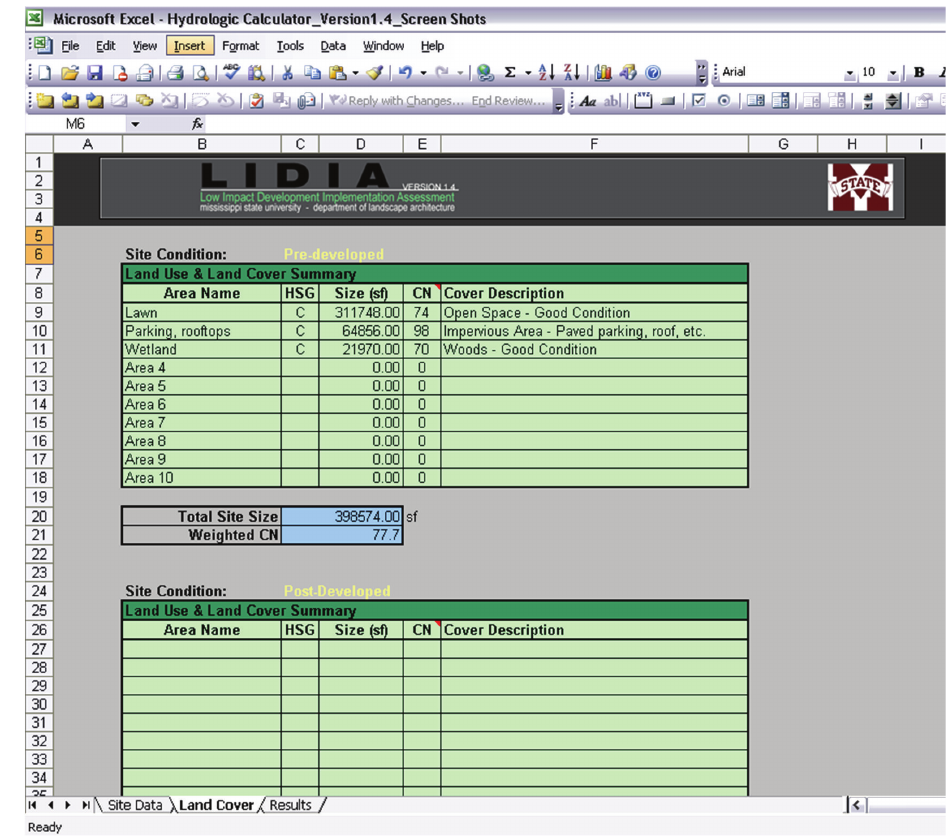
Figure 17: Latis-LIDIA Land Use and Land Cover Input